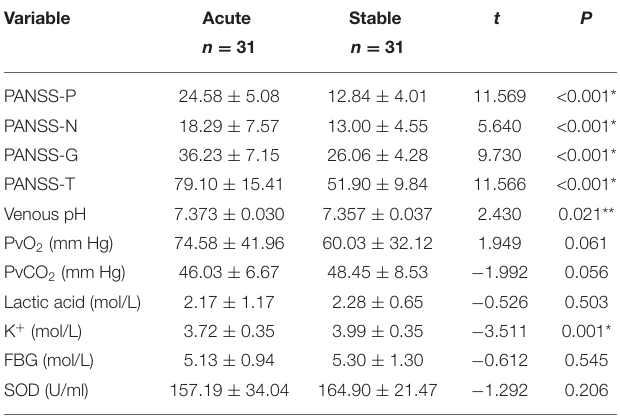
TABLE 8 | Comparison of effect indexes in acute and stable SCH patients (mean ± SD). Variable